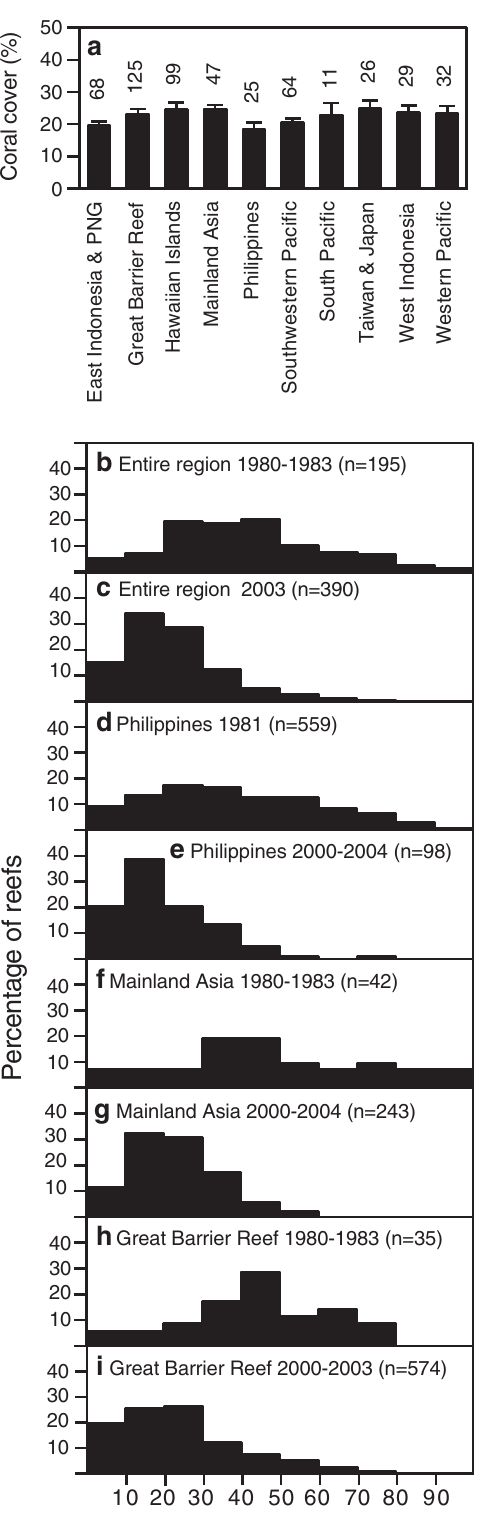
Figure 2. Coral cover in the Indo-Pacific. (a) Cover (means 6 1 SE) in ten subregions of the Indo-Pacific. Data are from 2003 for seven subregions and from 2002 for three subregions not adequately sampled after 2002 (Hawaiian Islands, Taiwan & Japan, and Western Pacific). Values above the bars are the number of reefs surveyed in each subregion. (b-i) Histograms illustrating percent coral cover in the Indo-Pacific and selected subregions during different periods. (d) is based on [45].